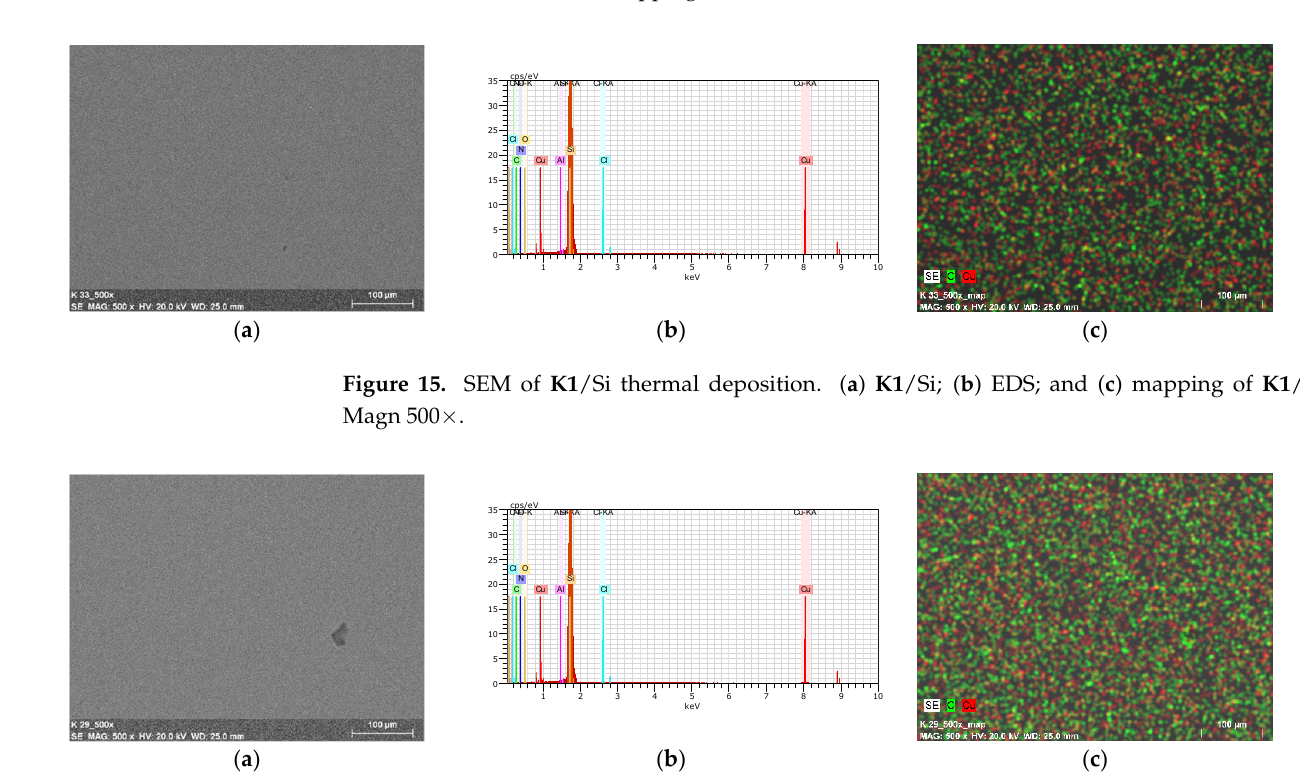
Figure 16. SEM of K2 /Si thermal deposition. ( a ) K1 /Si; ( b ) EDS; and ( c ) mapping of K1 /Si. Magn 500×.